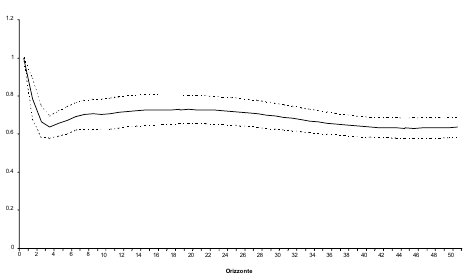
Figura 1b – Profilo di persistenza del settore Energia (modello M3 ).